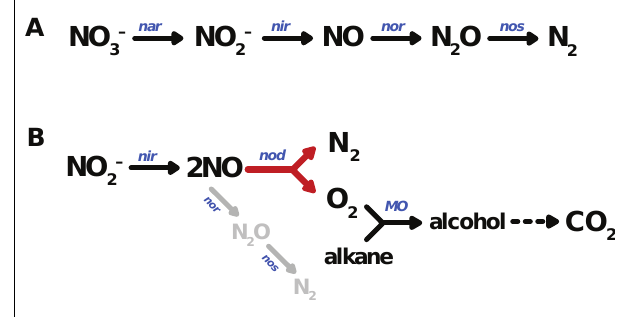
FIGURE 1 | Pathways of canonical denitrification (A) and proposed N 2 and O 2 production by NO dismutation (B) . nar, nitrate reductase; nir, nitrite reductase; nor, nitric oxide reductase; nos, nitrous oxide reductase; nod, nitric oxide dismutase, MO, monooxygenase.